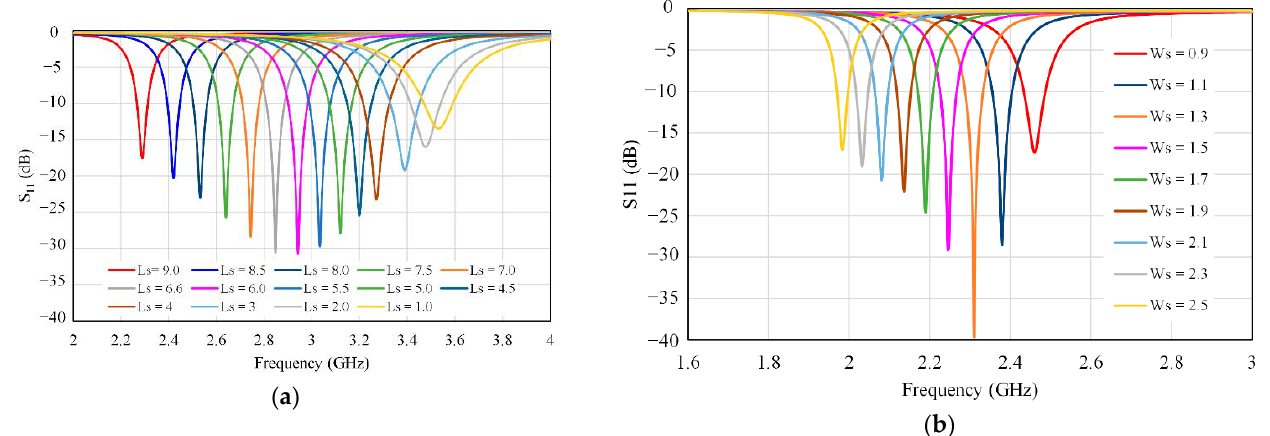
Figure 4. Frequency responses of slotted square patch antenna (single-band) ( a ) for different L S values, with W S = 1 mm, and ( b ) for different W S values, with L S = 8.5 mm.